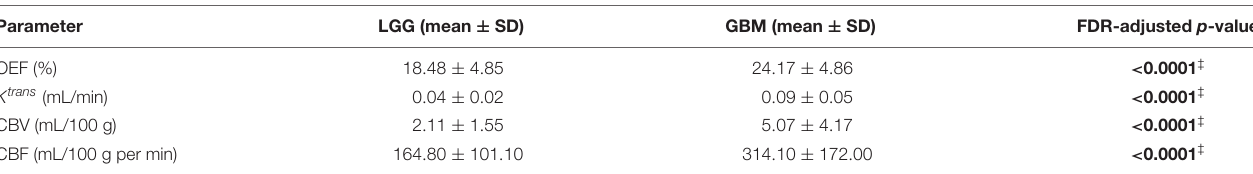
TABLE 5 | Comparison of biomarkers for WHO tumor